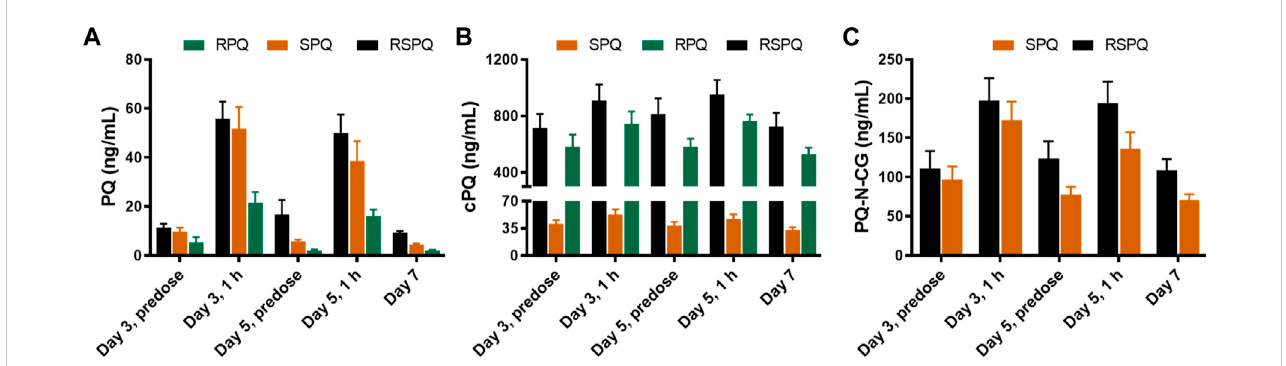
Concentrations of PQ (A) and its metabolites (B,C) in plasma of G6PDn subjects after oral administration of PQ enantiomers or racemate for 7 days. Bar graphs are presented as mean with SEM ( N =